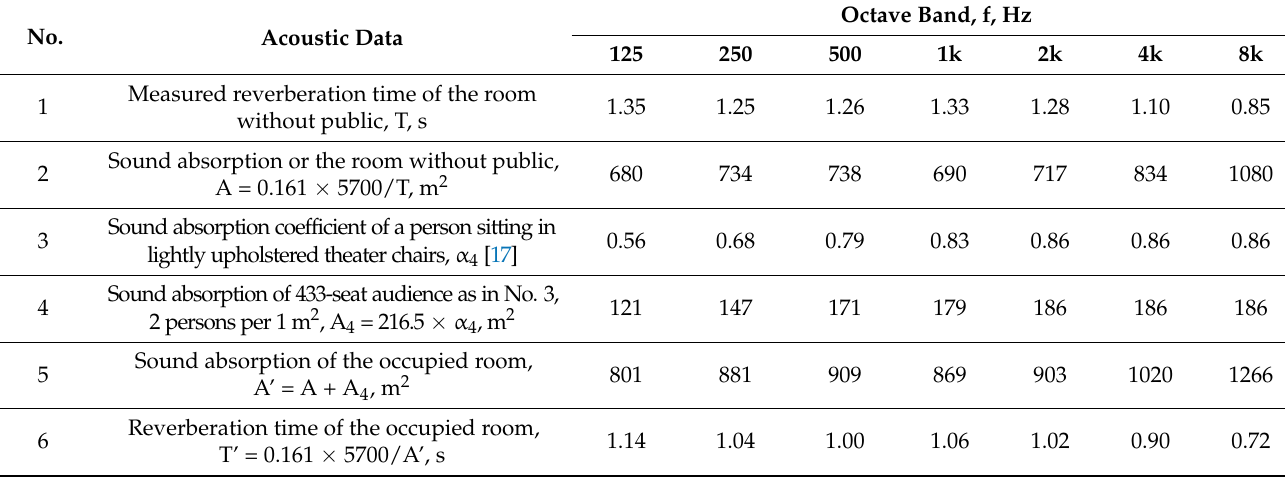
Table A2. Calculations taking into account the influence of the audience on the reverberation time in the multi-purpose hall.